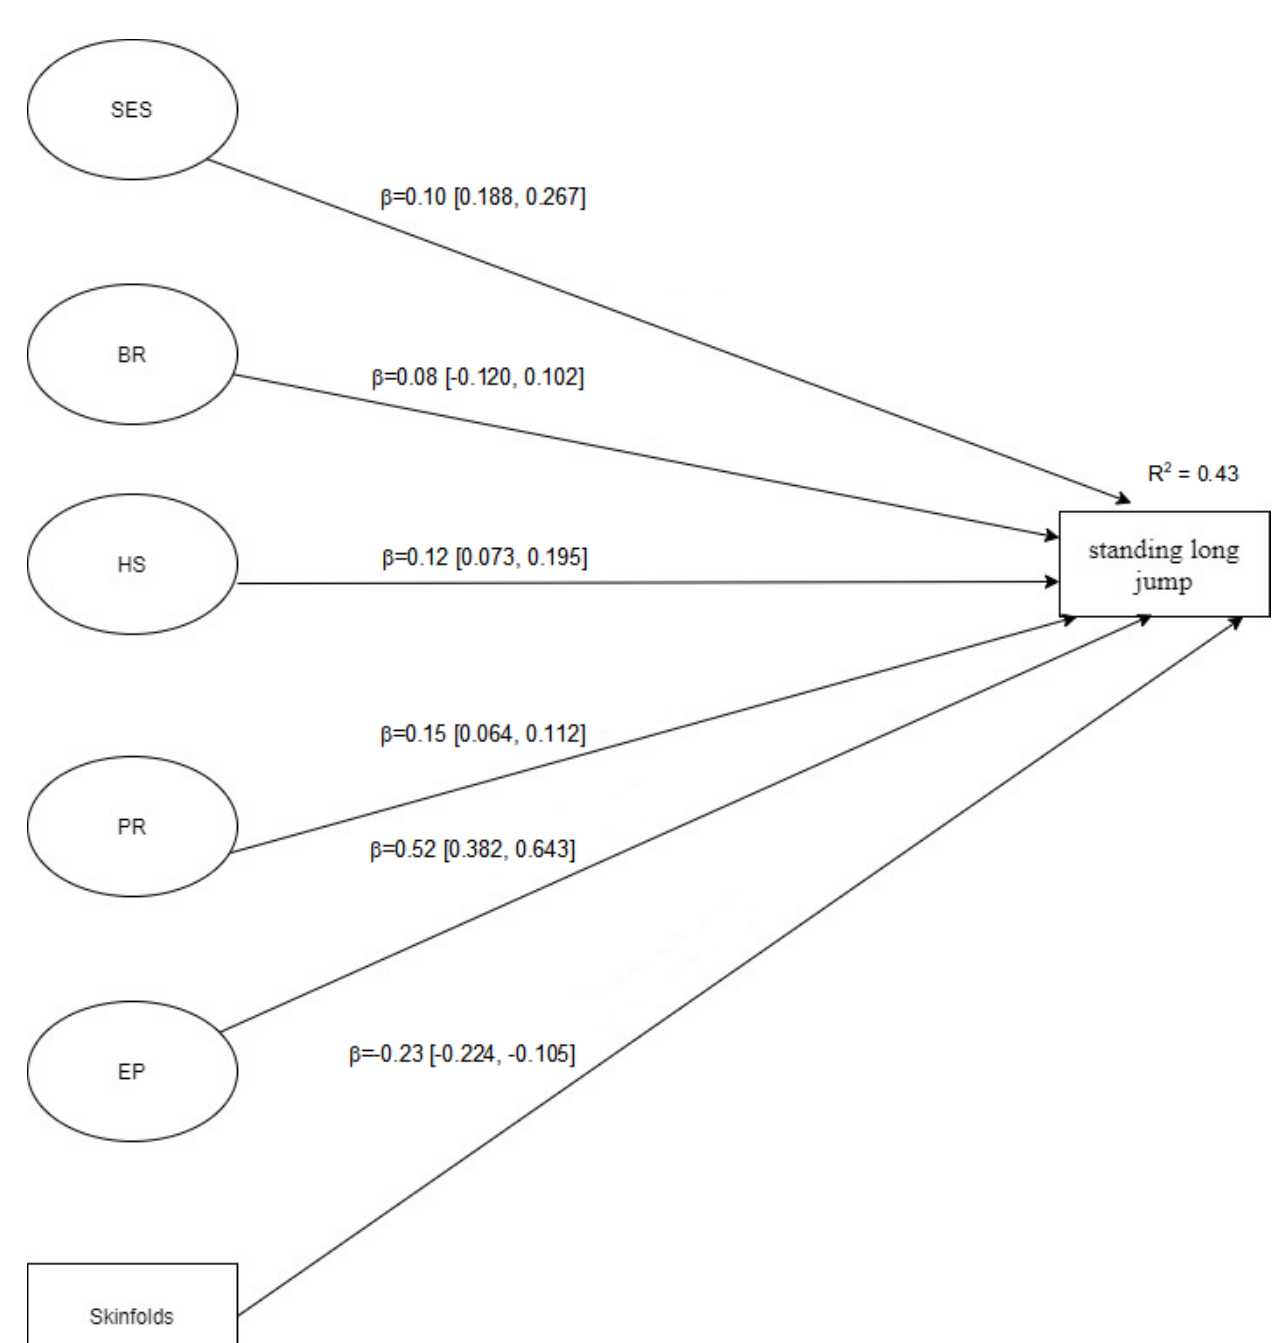
Figure 2. Structural model for standing long jump. Note. SES = socio-economic status; BR = brotherhood relationship; HS = house space; PR = peer relationships; EP = educational practice; skinfolds = sum of 5 different skinfolds, including bi-acromial breadth, hip breadth, upper arm girth, standing calf girth, and upper limb length.